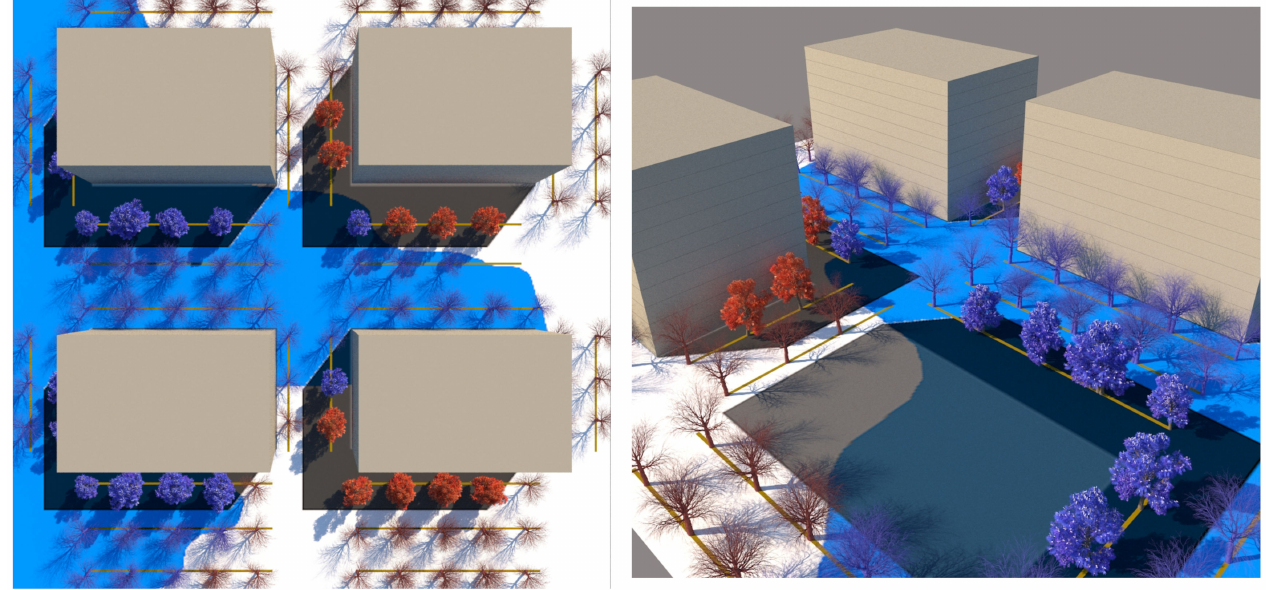
Figure 10. LEFT shows the four map-controlled proxy-object tree scatters with blue deciduous models occurring in flood + solar preservation, red deciduous models occurring in dry, solar preservation, blue evergreen models in flood overshadowing, and red evergreen models in dry overshadowing. Note: flood is depicted in blue for clarity. RIGHT shows a perspective view of the intersection model (with a foreground building mass removed). The models are colour- and form-coded to their respective condition. These models are now ready to be adjusted to the requirements of solar exposure protection (crown-form, canopy dimensions, position and spacing). Image by authors using multi-criteria street design decision support modelling approach in Autodesk™ 3ds